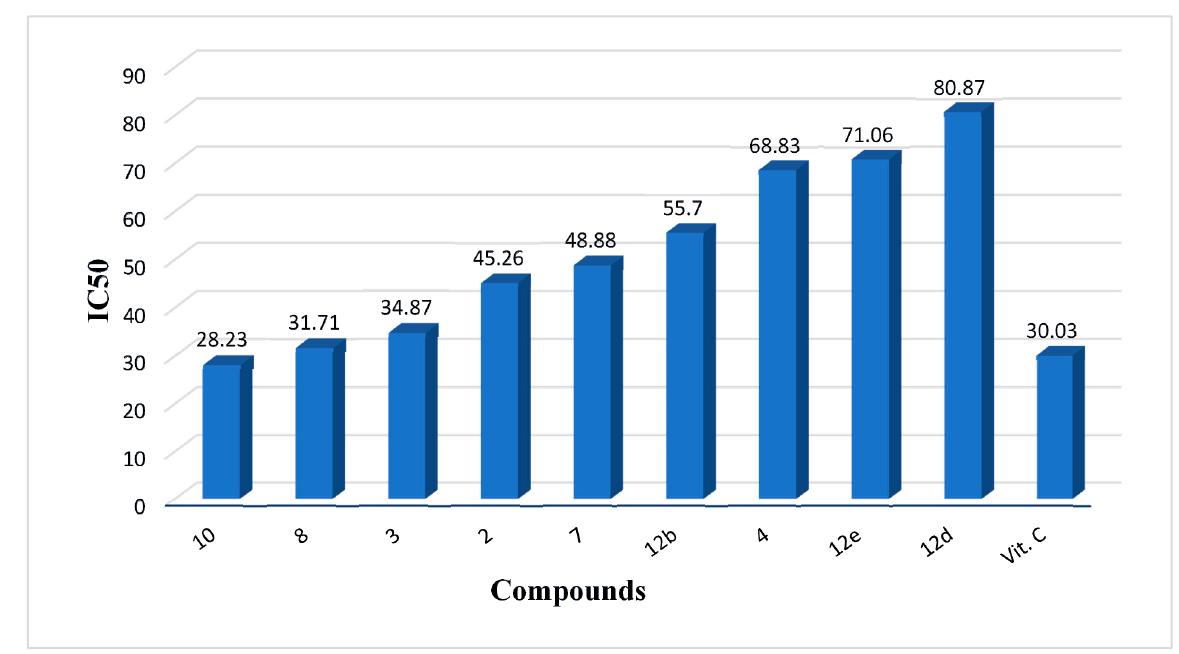
Figure 2. ABTS radical scavenging effect of (thiophen-2-yl)-1 H -indole derivatives with standard ascorbic acid.